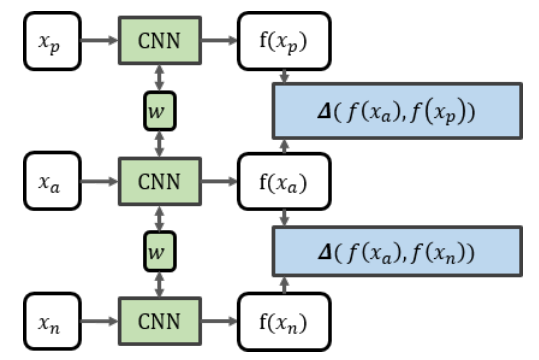
Figure 3. Triplet architecture. Three input images are propagated through the same CNN architecture. The CNN branches share their weights w . The L2 distances ∆( f ( x a ) , f ( x p )) and ∆( f ( x a ) , f ( x n )) of the resulting feature vectors are the basis for calculating the loss to be minimized in training.